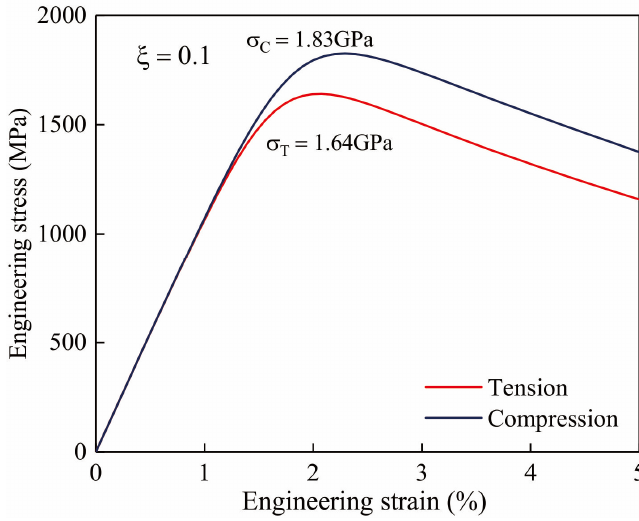
Figure 2. Simulated engineering stress-strain curves.